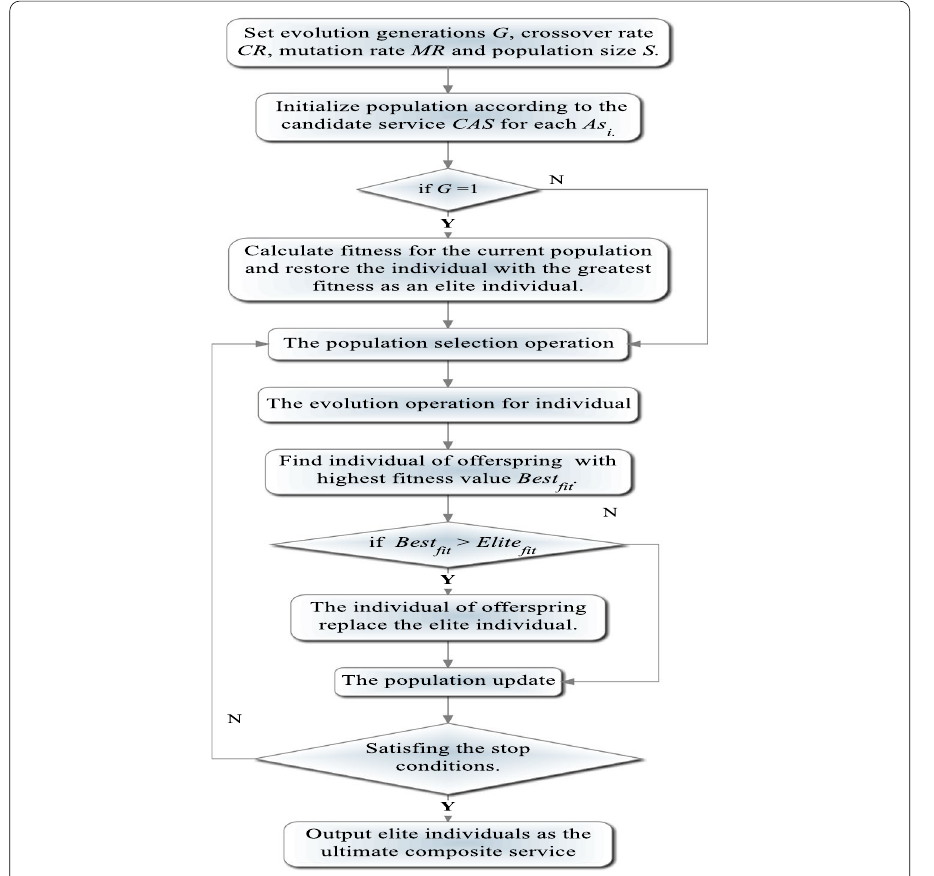
Fig. 2 The process of enhanced genetic